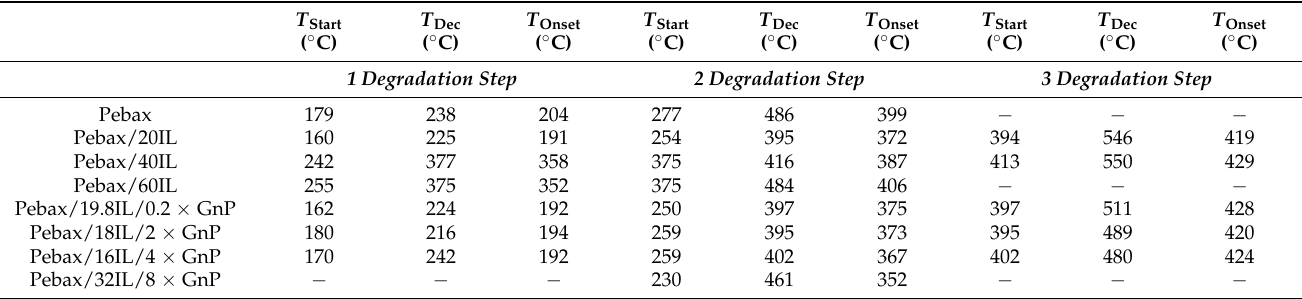
Table 2. Thermal properties obtained by TGA, temperature at which degradation begins; T Start , temperature at which degradation ends; T Dec , and the onset temperature; T Onset , of the different